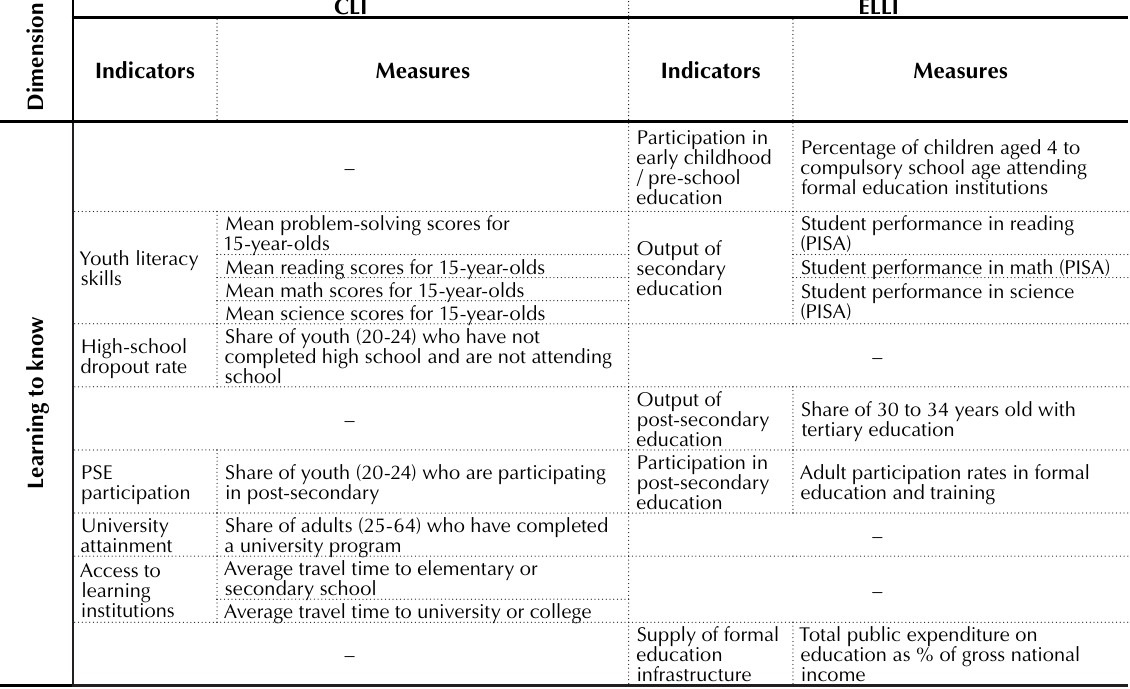
Table A1. The dimension of learning to know Source: Developed by the authors on the basis of the 2010 Composite Learning Index (2010) and Hoskins, Cartwright, and Schoof (2010).